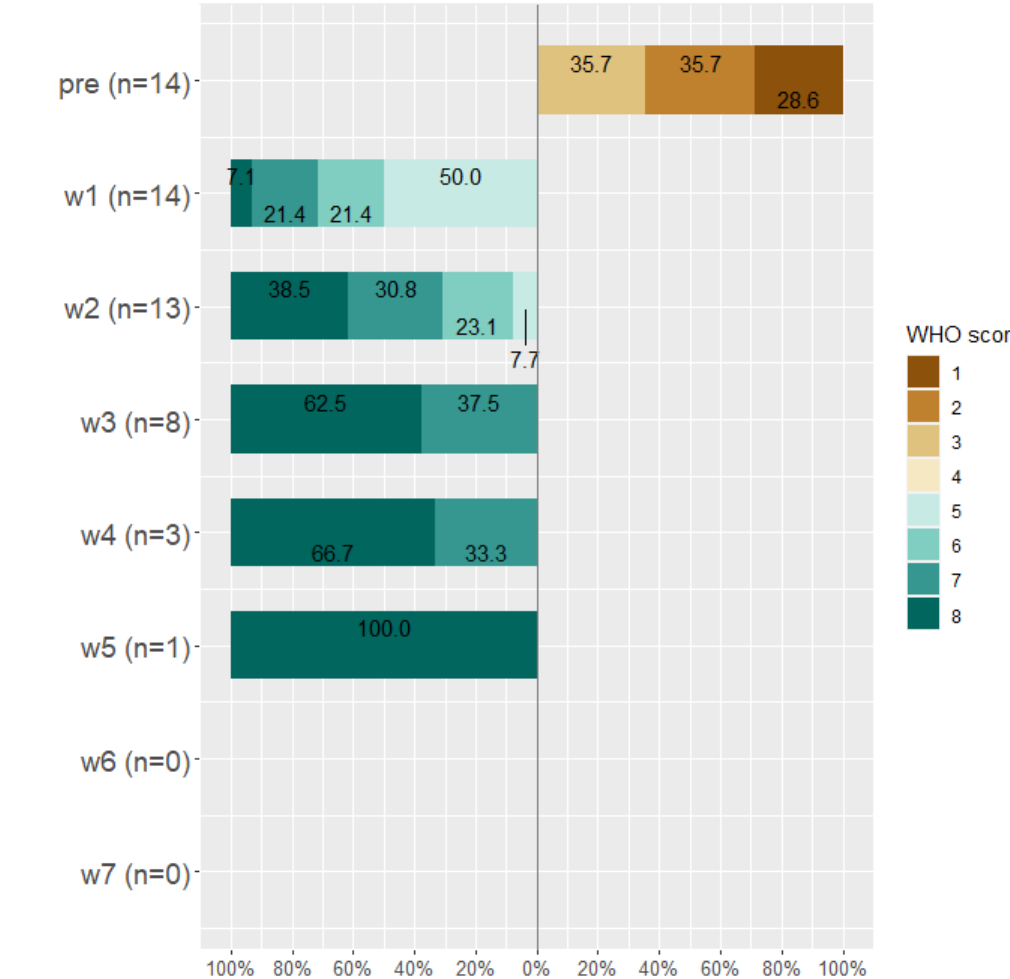
Figure 5. WHO score for worsened patients ( n = 14) before taking Tocilizumab and at weeks 1, 2, 3, 4, 5, 6, and 7 after Tocilizumab administration.